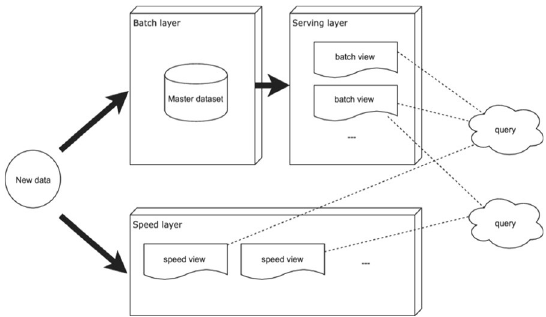
Fig. 1 The Lambda architecture (Yang et al.